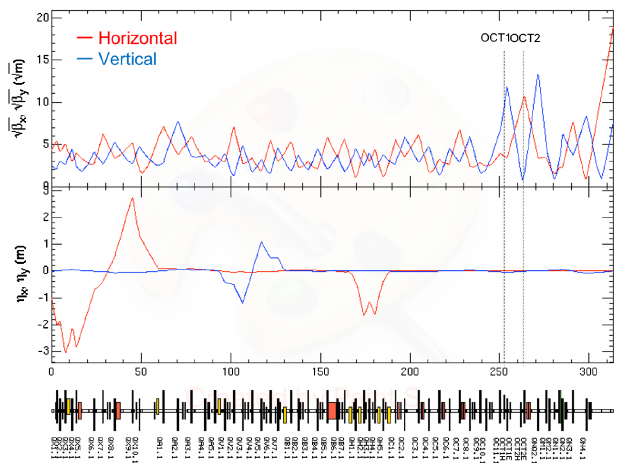
FIG. 10. Beam optics and beta function of nonlinear beam expander consisting of octupole magnets.